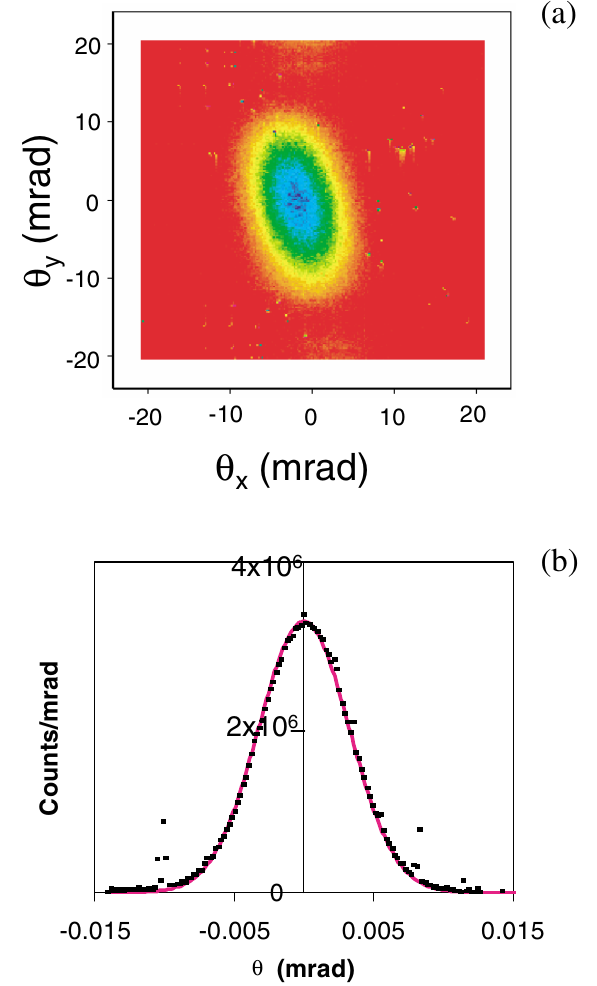
FIG. 2. (Color) Single shot x-ray beam image detected with the x-ray CCD (a), and y integrated background subtracted inten- sity profile vs the divergence angle in x for the same image (b).